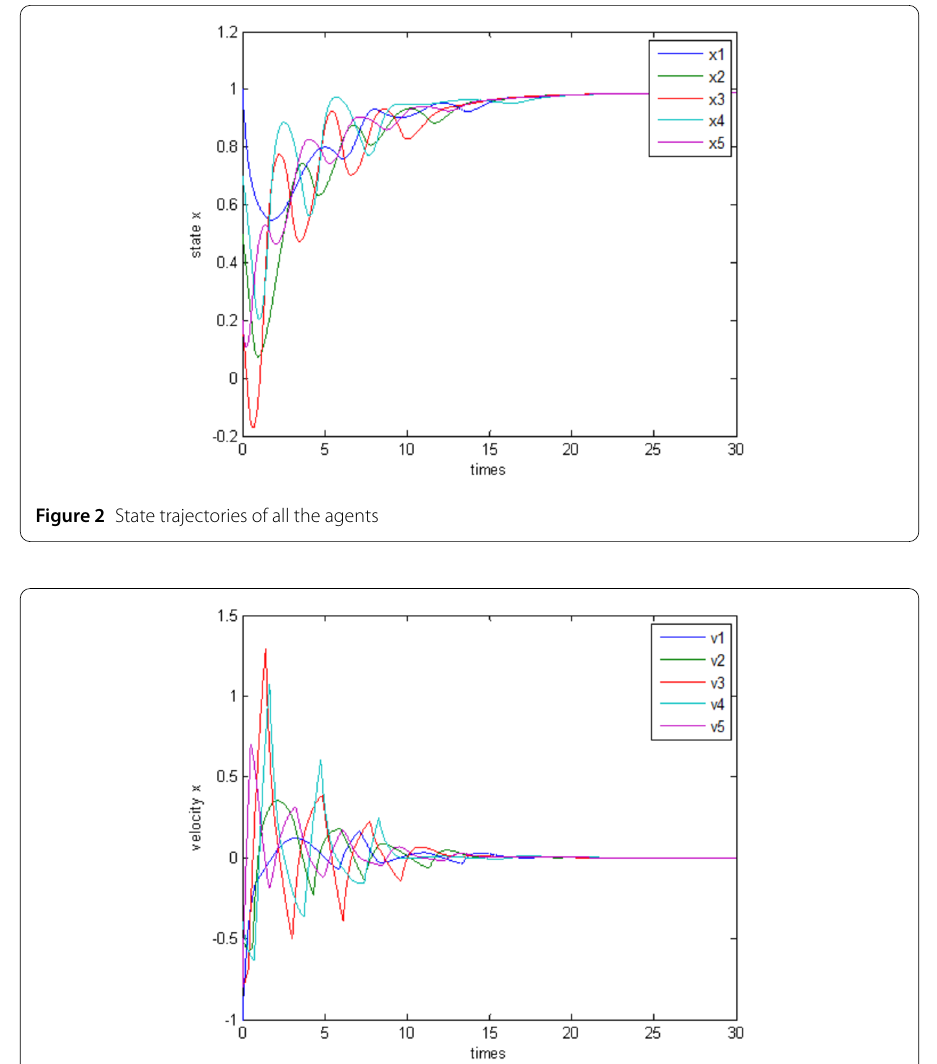
x 3 (0) = [0.2,–0.8] T , x 4 (0) = [0.7,–0.4] T , and x 5 (0) = [0.2,–0.8] T . The initial value of